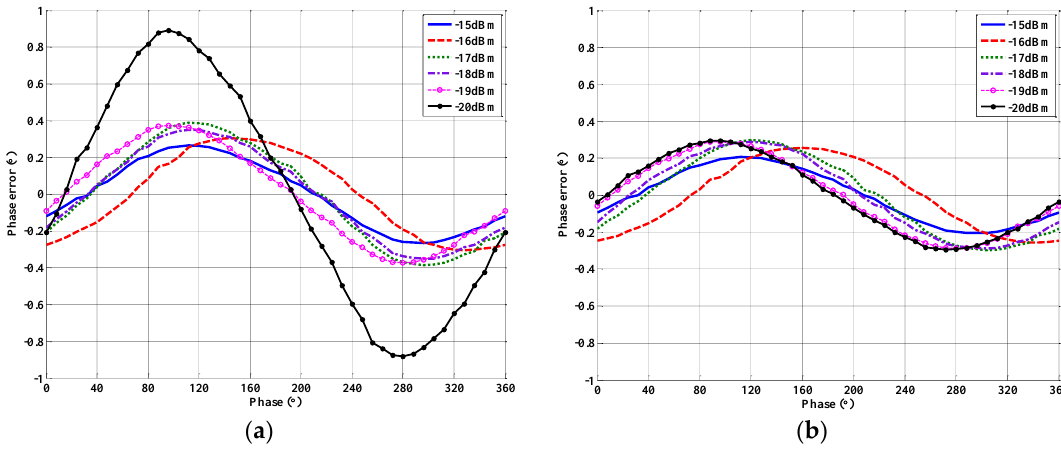
Figure 9. ( a ) The uncalibrated phase error at different input power levels; and ( b ) the calibrated phase error at different input power levels. Table 3. Specifications for the uncalibrated and calibrated output phase errors.